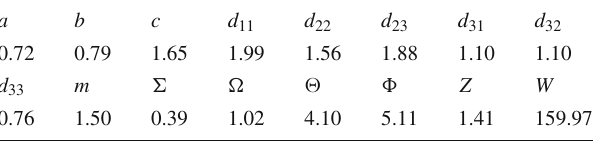
Table 4 Set of parameter assignments which lead to a final baryon asymmetry close to the cosmological observations. See text for further